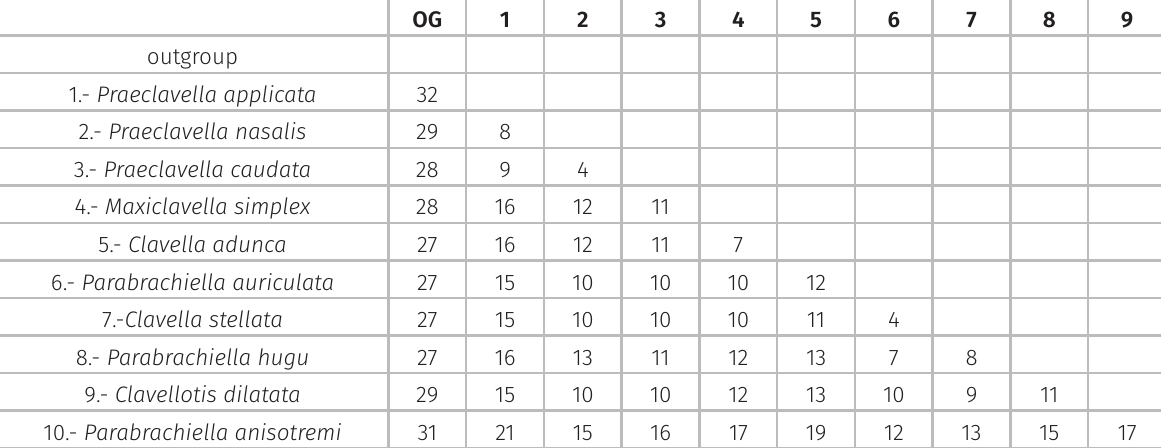
Table II. Genetic distances matrix (uncorrected p-distance) for copepods used in this manuscript. The percentage values are derived from the 28S